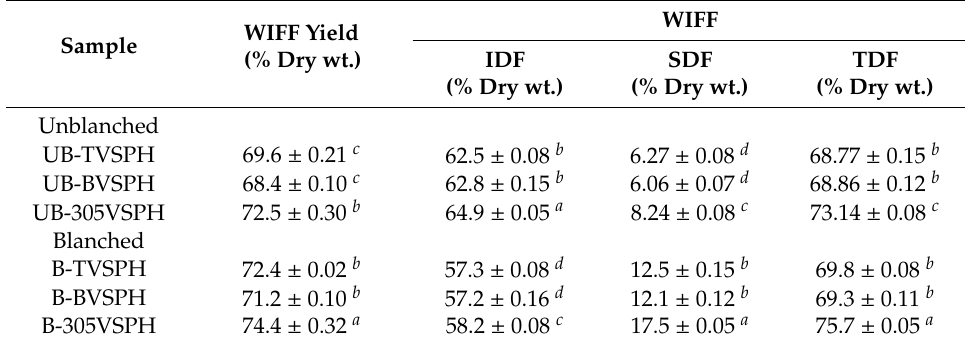
Table 2. The yield of water-insoluble fiber enriched fraction (WIFF) in unblanched and blanched vegetable soybean pod hulls and its dietary fiber content w .